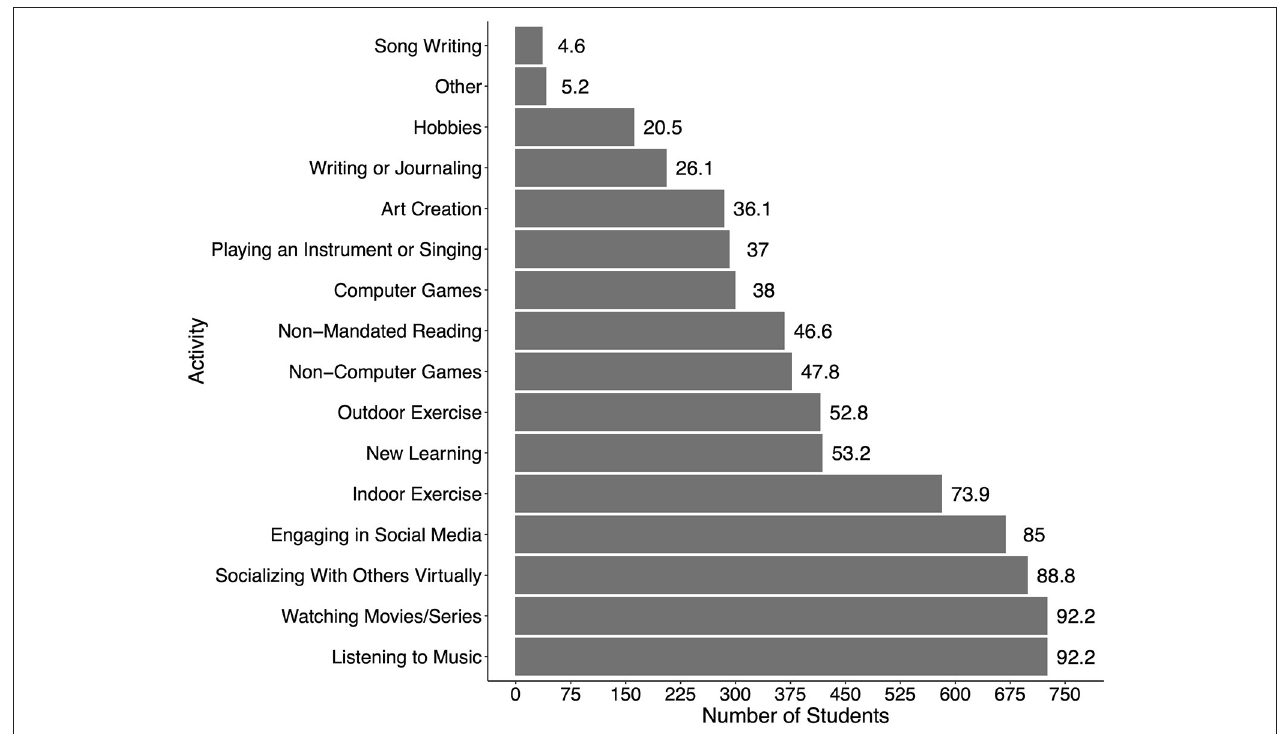
FIGURE 1 | Number of students out of 786 who reported engaging in each extra-curricular activity. Numbers at the end of each bar indicate the % of